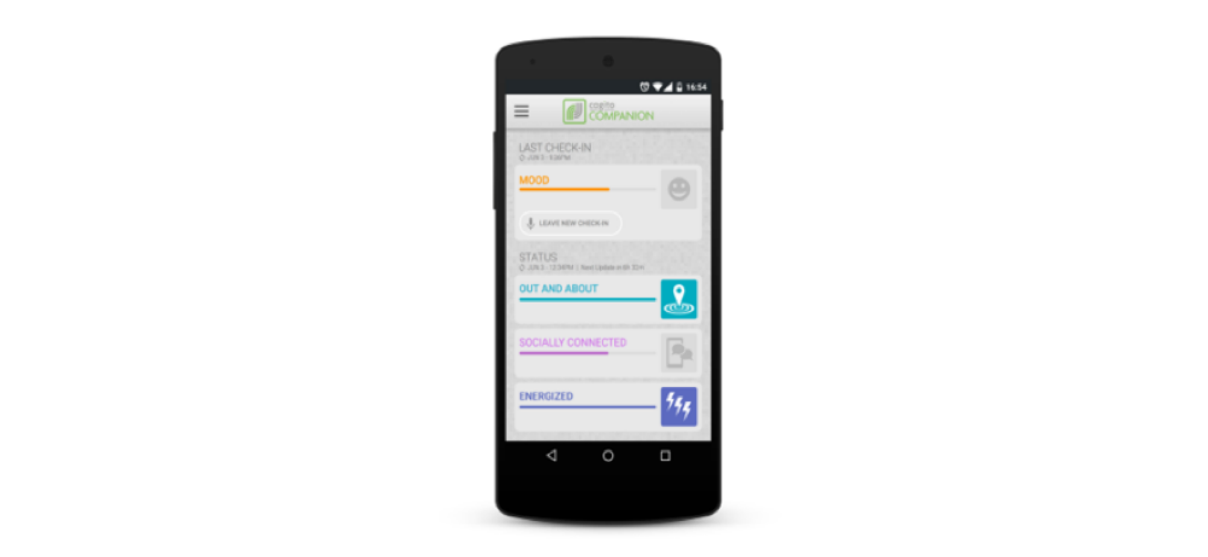
Figure 1. Cogito Companion